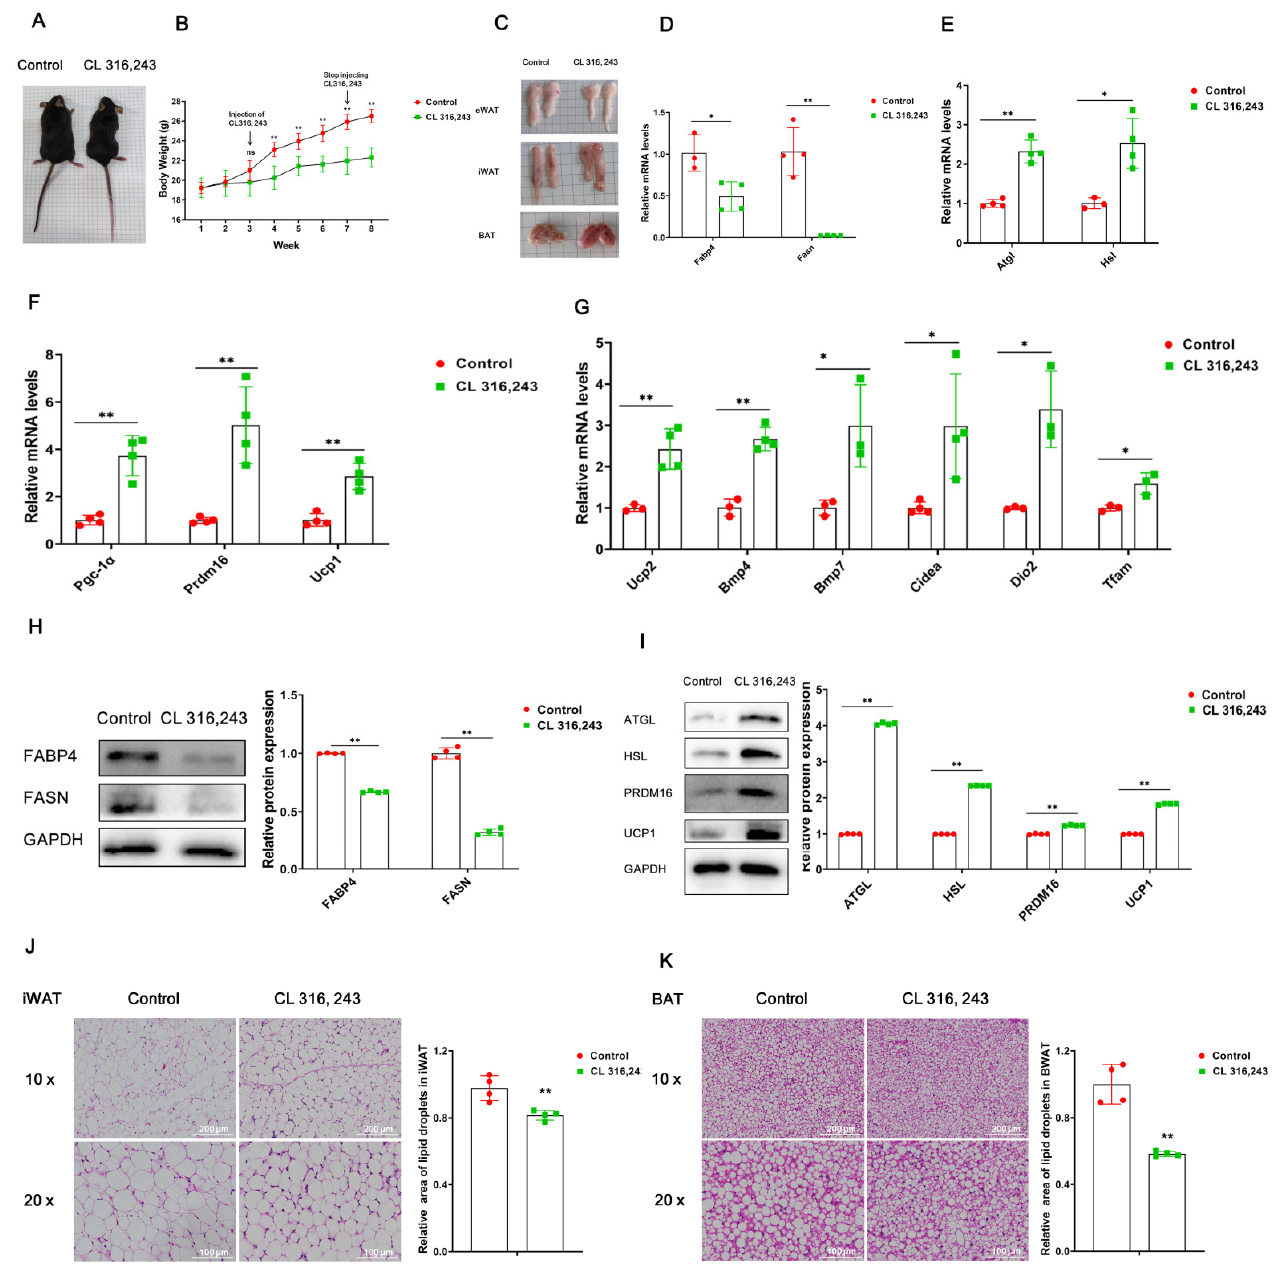
Figure 1. Construction and validation of the white fat browning mouse model. Note: The mice were injected with CL316,243 (1 mg/kg) every two days for 4 weeks, and after 2 weeks of stabilization, total RNA and total protein were extracted from iWAT of the mice. ( A ) Morphological diagram of mice ( n = 5). ( B ) Change curve of mouse body weight ( n = 5). ( C ) Morphological diagram of eWAT, iWAT and BAT ( n = 5). ( D – G ) mRNA expression levels of genes related to lipid synthesis, lipolysis, white lipid browning and mitochondria ( n = 4). ( H , I ) Protein expression levels of genes related to lipid synthesis, lipolysis and white lipid browning ( n = 3). ( J , K ) HE staining of mouse iWAT and BAT, bar: 200 μ m ( n = 4). Values are mean ± SD compared to controls. * p < 0.05, ** p < 0.01.